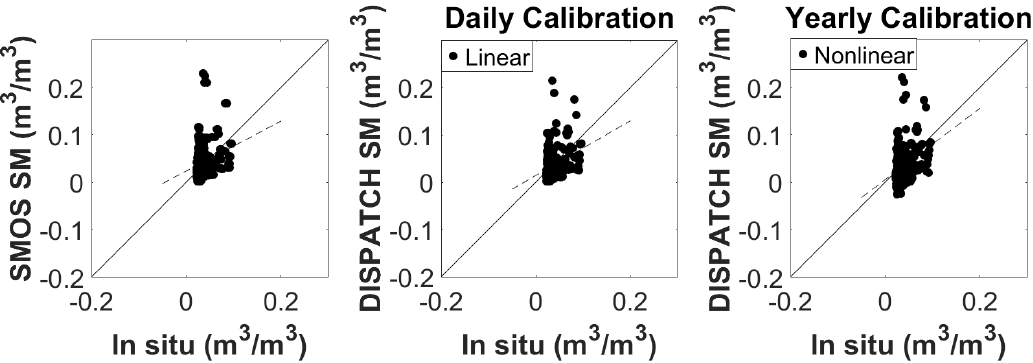
Figure 9. The SMOS and DISPATCH SM are plotted against measurements collected from sensors over the MOR3